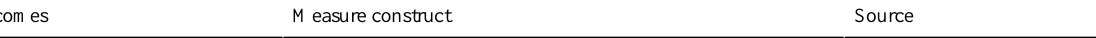
Table 2. Summary of the study outcome measures.